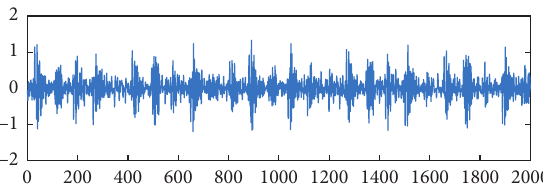
Figure 7: A vibration signal sample of inner race fault.